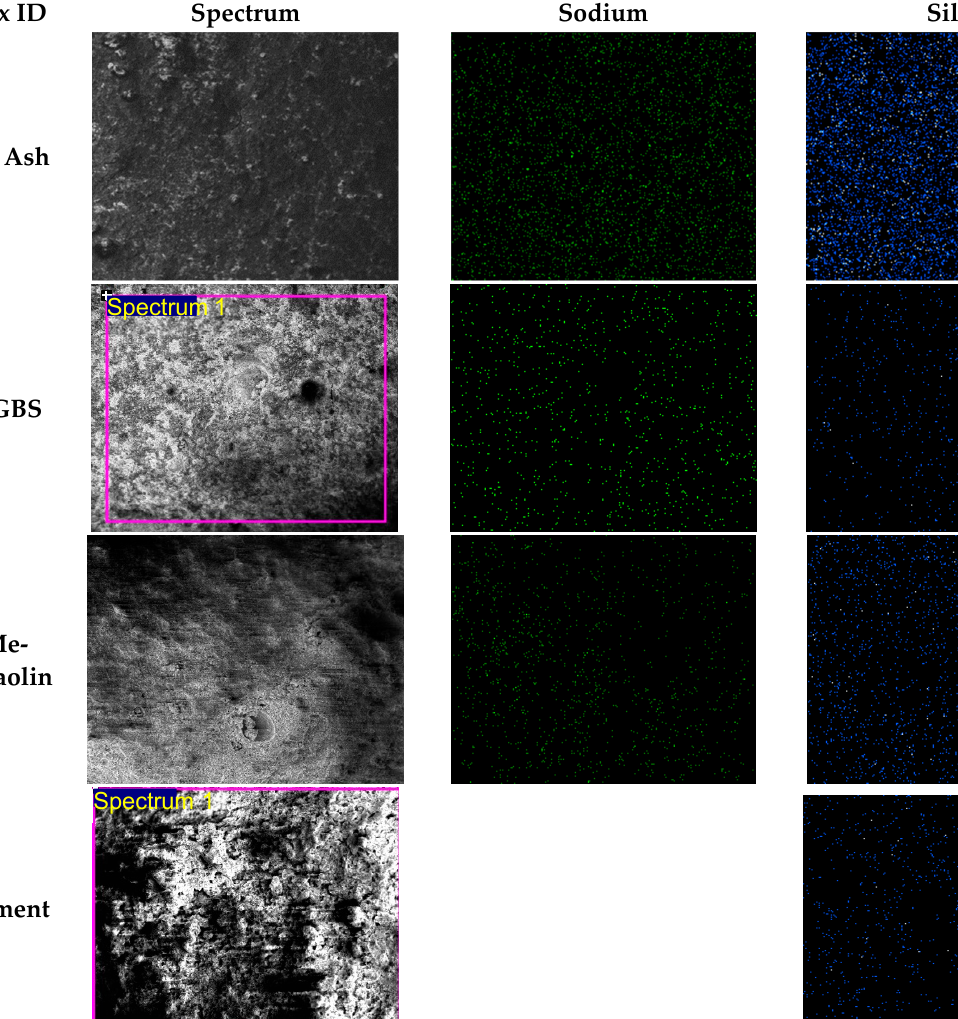
Figure 12. EDS mapping of elements of pastes.